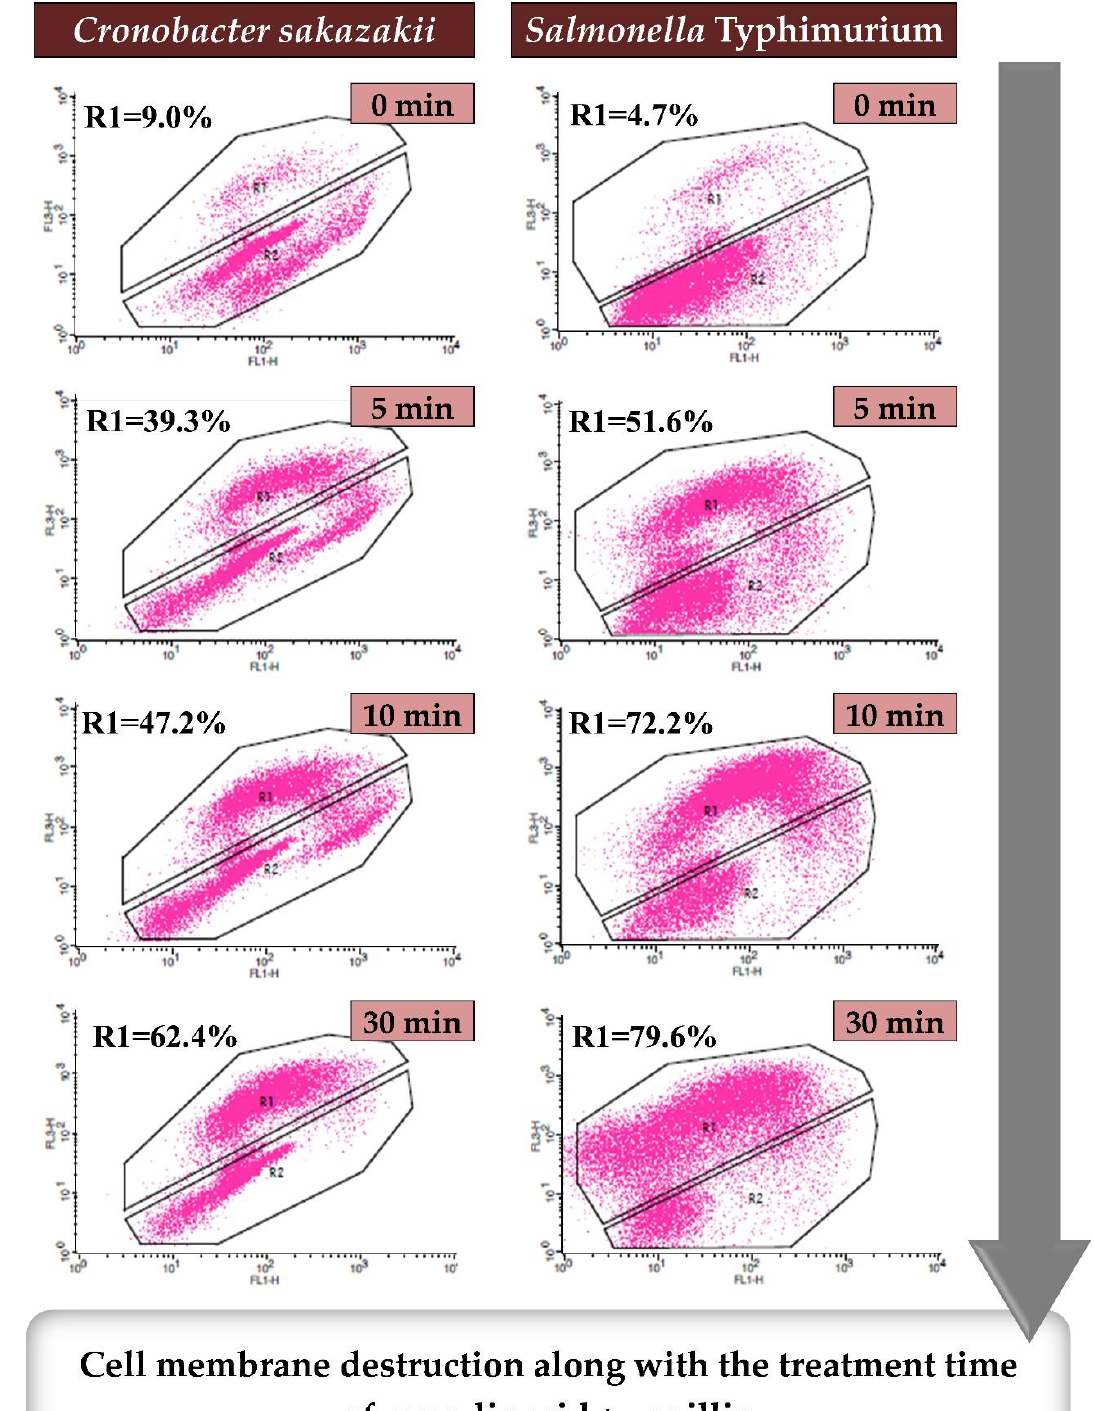
Figure 2. Time-dependent flow cytometry plots for the demonstration of the cell membrane destruction by the EO-based antibacterial complex against Cronobacter sakazakii and Salmonella Typhimurium treated with caprylic acid + vanillin. This figure was adopted from Choi et al. [62].